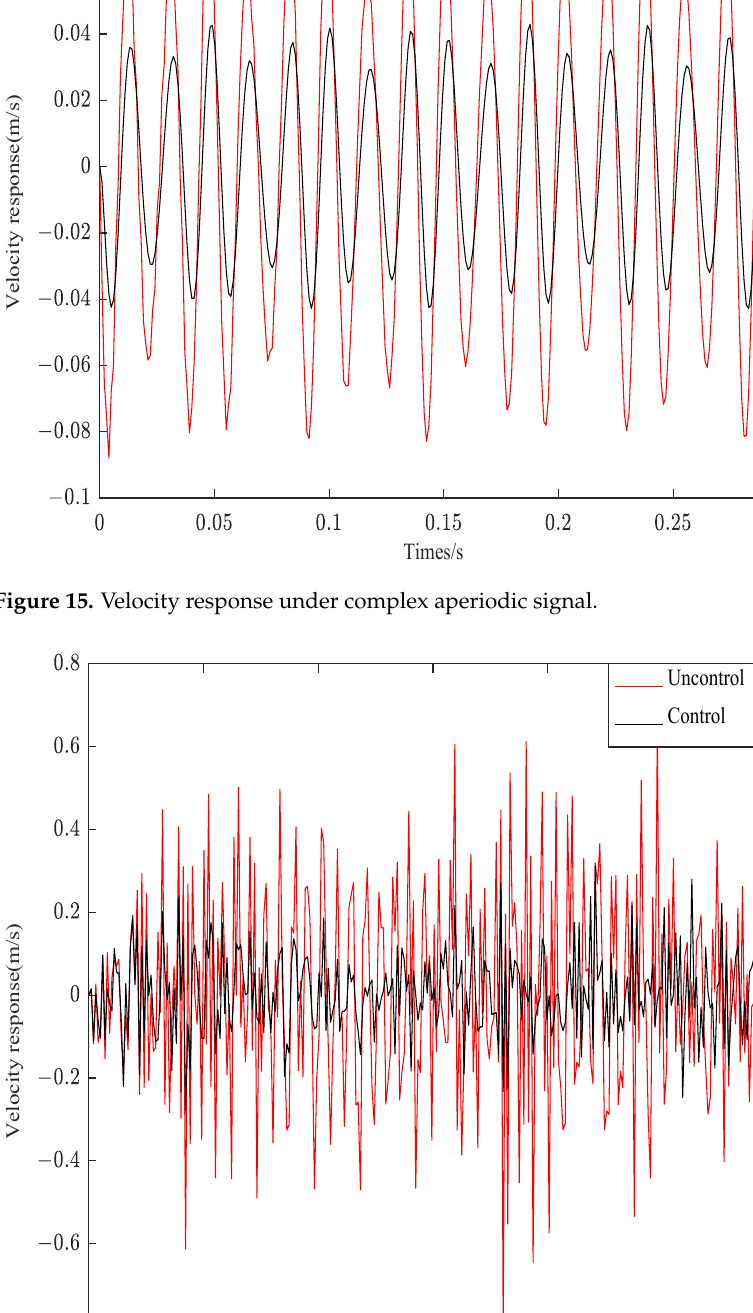
Figure 16. Velocity response under Gaussian white noise.